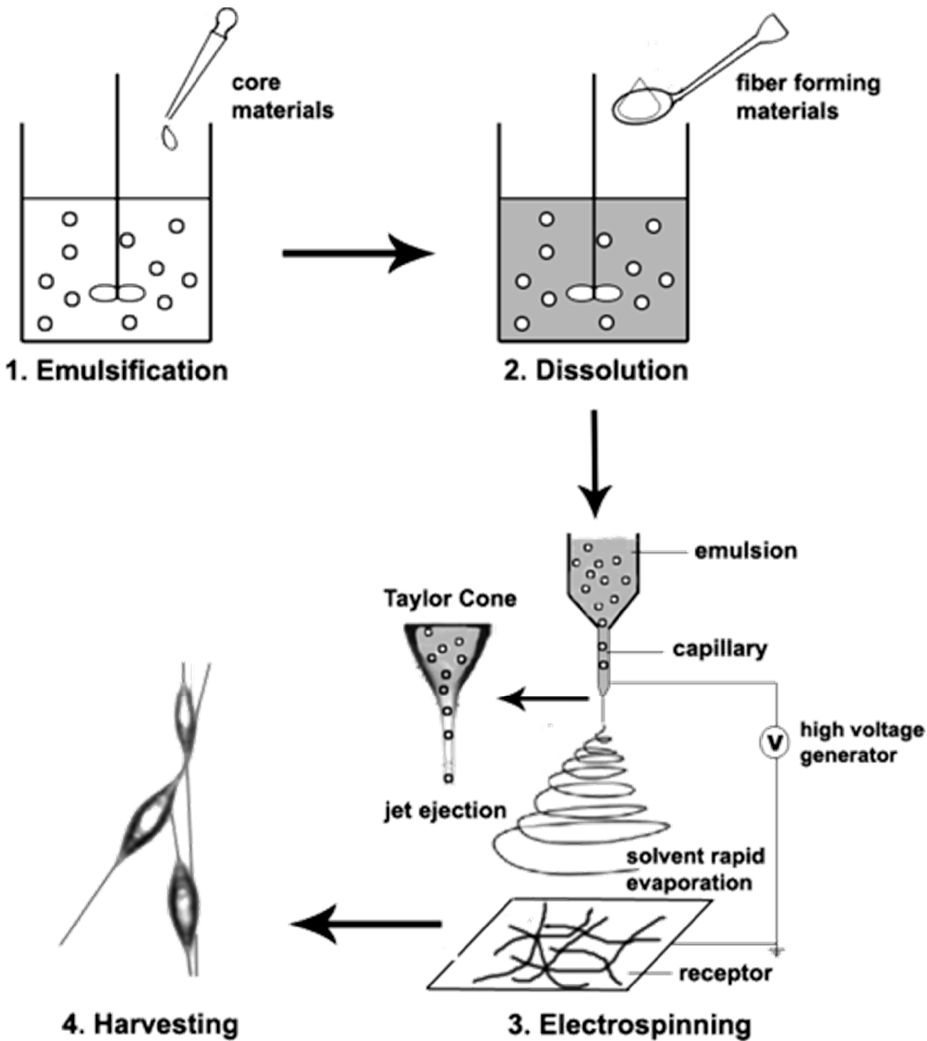
Figure 15. Scheme of a simple emulsion electrospinning process. Reproduced with permission from [223].